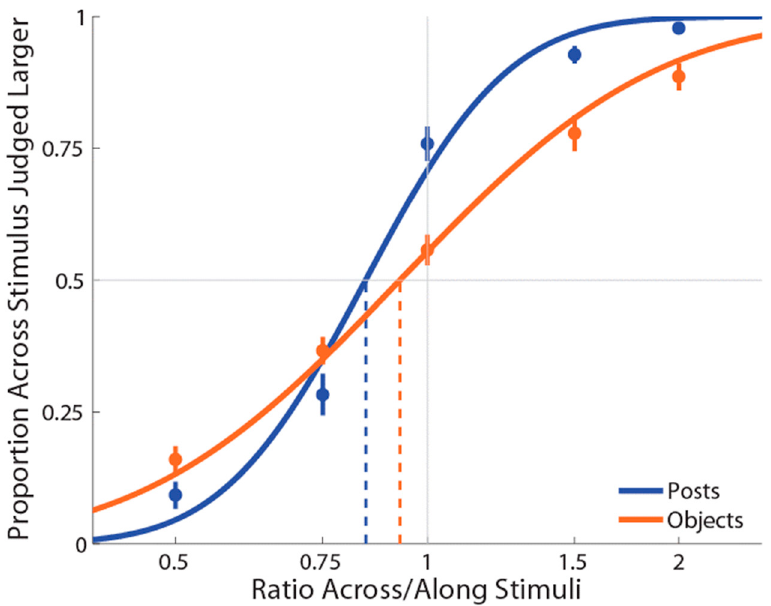
Figure 3. Experiment 2 results in which the curves (blue for posts stimulation and orange for objects stimulation) are the cumulative Gaussian functions fit with least-squares regression. Vertical lines represent points of subjective equality (i.e., where the curve crosses 50%). Error bars represent the standard error of the mean (±SEM).